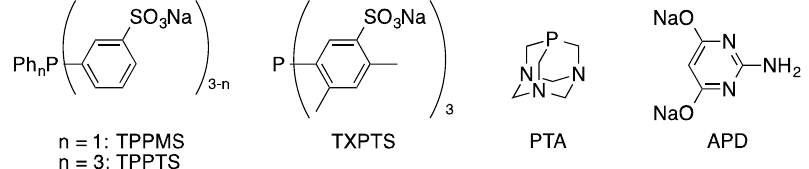
Figure 2. Hydrophilic ligands commonly applied in nucleoside cross-coupling